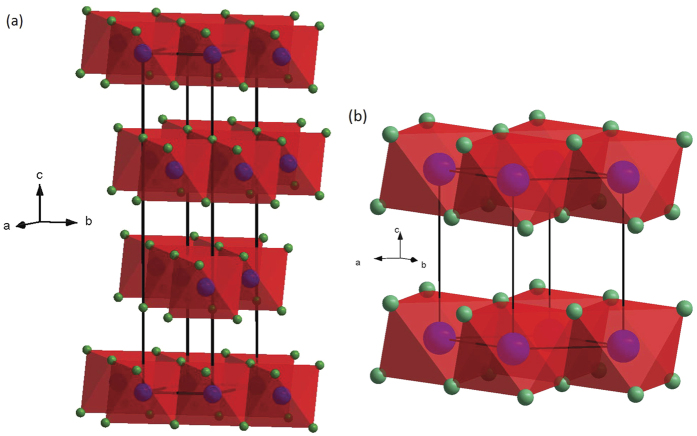
Schematic representations of: (a) CdCl2-type and (b) CdI2-type crystal structures of MgCl2. Blue and green spheres indicate Mg and Cl anions respectively.